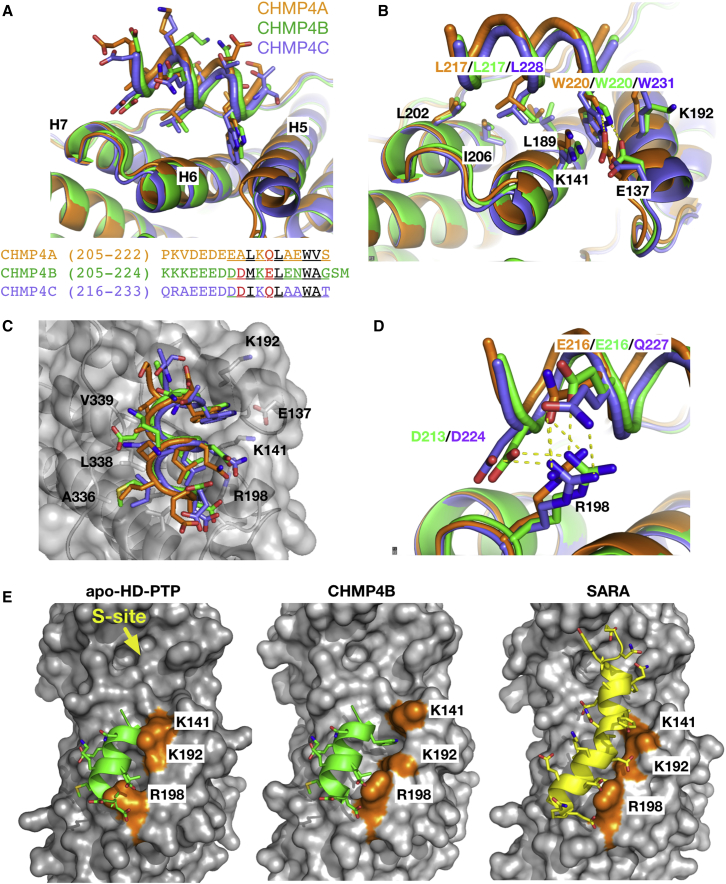
Analysis of the HD-PTPBro1-CHMP4 Interfaces(A) Ribbon representation of the structures of the three HD-PTPBro1-CHMP4 complexes (4A, orange; 4B, green; 4C purple) showing the interface at the common binding site on the hydrophobic concave region of HD-PTPBro1. Peptide side chains are shown as sticks. The sequences of each peptide used in the crystallization are shown below, where residues visible in the structures are underlined, hydrophobic residues are in black, and acidic/polar residues are in red.(B) Detail of the binding site showing residues in HD-PTPBro1 (black labels) that form interactions with the conserved Leu and Trp residues in the peptides (labeled according to color code for each peptide).(C) Surface representation of HD-PTPBro1 with the three peptides superimposed showing the binding into the two hydrophobic pockets and the HD-PTPBro1 residues involved both at the C-terminal region (left side) and at the common site (right side) labeled in black.(D) Detail of the electrostatic interactions between HD-PTPBro1 R198 and the acidic and polar residues in the CHMP4 peptides.(E) Surface representation of the structures of apo-HD-PTPBro1 with the CHMP4B peptide superimposed (left), HD-PTPBro1-CHMP4B complex (center), and HD-PTPBro1-SARA complex (right). Colored in orange and labeled in black are the residues that block the hydrophobic pockets in the apo structure and that undergo conformational rearrangements in the complexes with the peptides. In contrast, the S-site pocket is readily available in the apo structure.